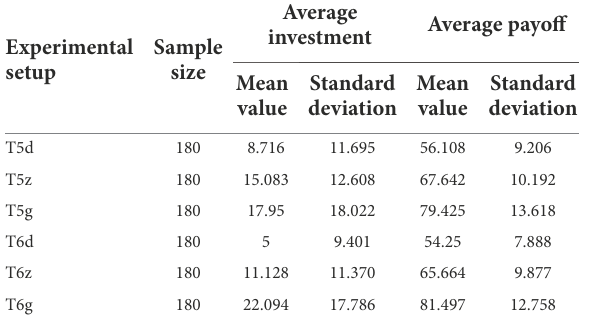
TABLE 4 The leader type transformation and individual investment and